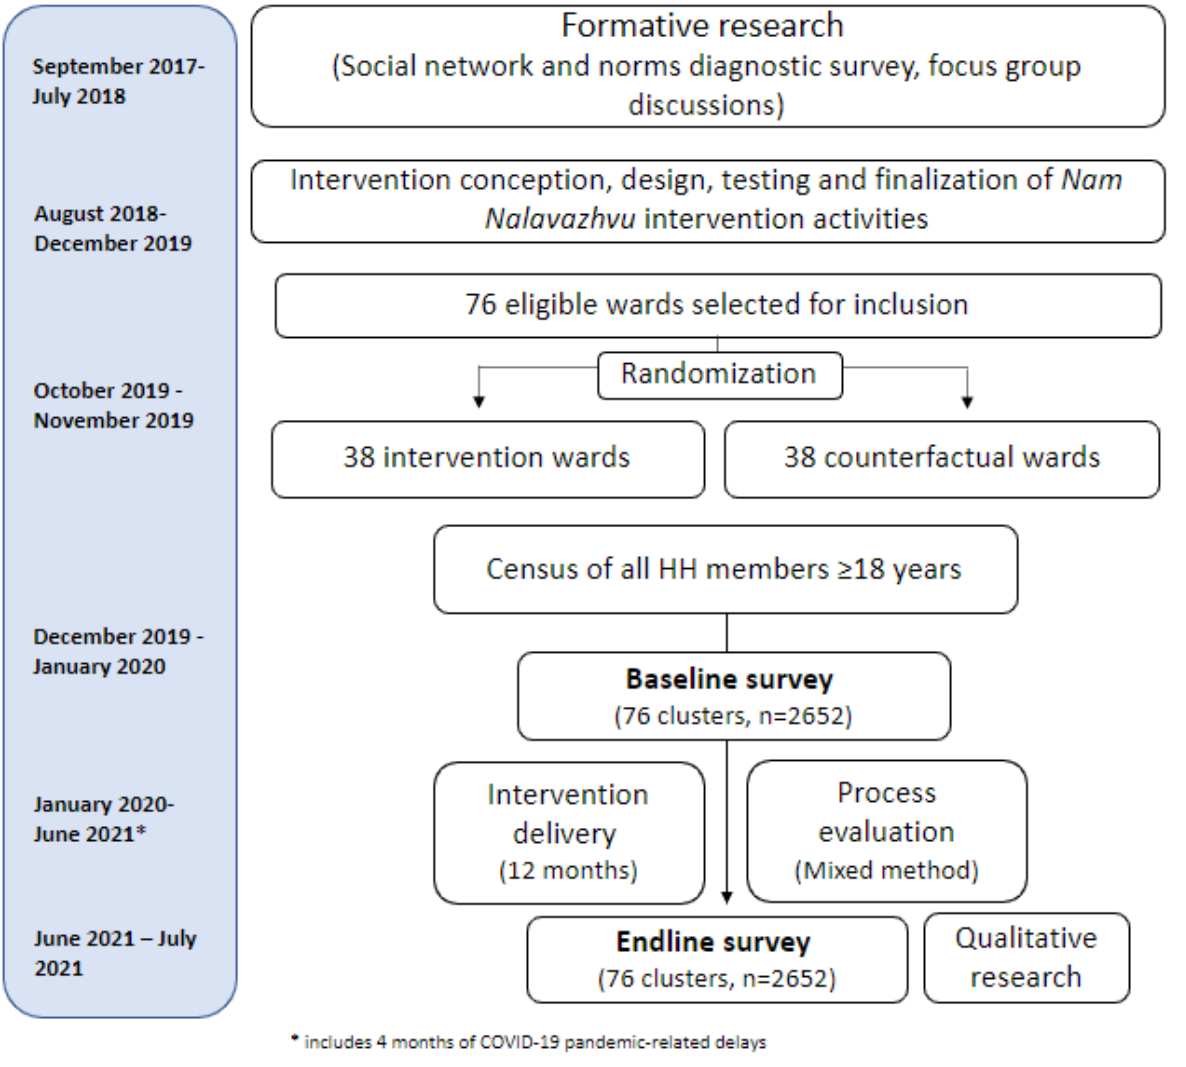
Figure 2. Summary of overall study design, including the timeline for impact evaluation to assess the effectiveness of the Nam Nalavazhvu intervention in Tamil Nadu, India. HH: